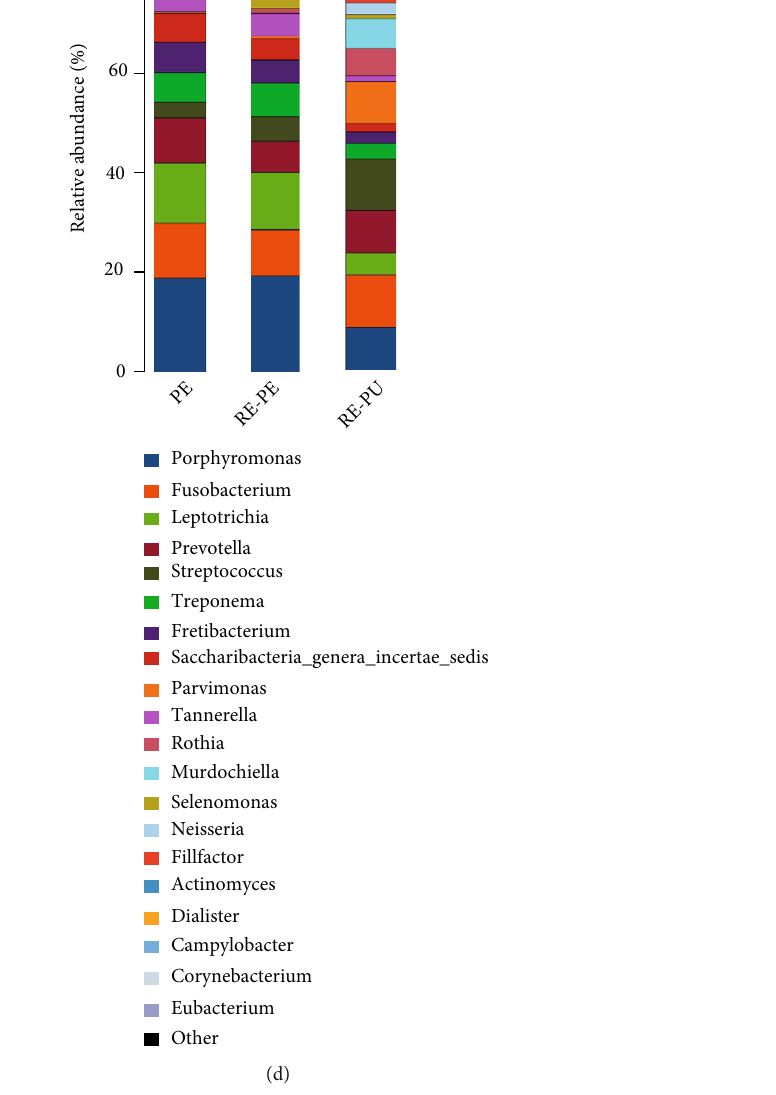
Figure 1: The analysis of microbial community structure of PE, RE-PE, and RE-PU groups. (a, b) The boxplot diagrams show alpha diversity index among PE, RE-PE, and RE-PU. (c) The plot of principal coordinates analysis (PCoA) shows intergroup distances by 2 principal coordinates. (d) The relative abundance of bacterial taxa at the genus level of PE, RE-PE, and